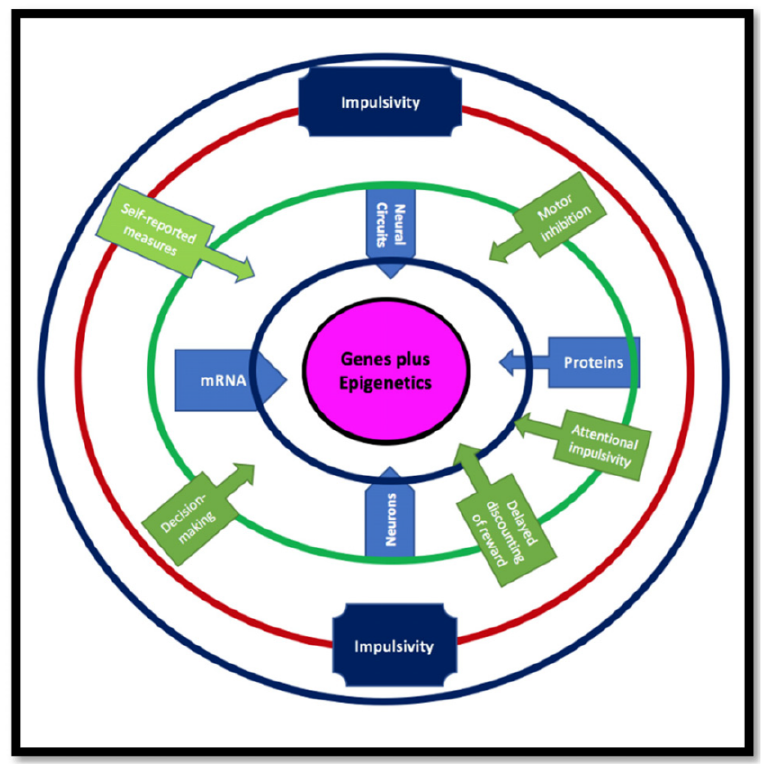
Figure 1. Impulsivity is a hereditary, disease-associated trait that may be evolutionarily beneficial as an endophenotype for genetic innovation resulting in behavioral adaptation to a challenging environment. More specifically, impulsivity is not a singular construct but a complex trait. Multiple laboratory behavioral tasks and self-report measures are used to assess aspects of impulsivity. Different neural circuits and genes are impacted by epigenetics, which also has pleiotropic effects on behaviors that modulate impulsivity.